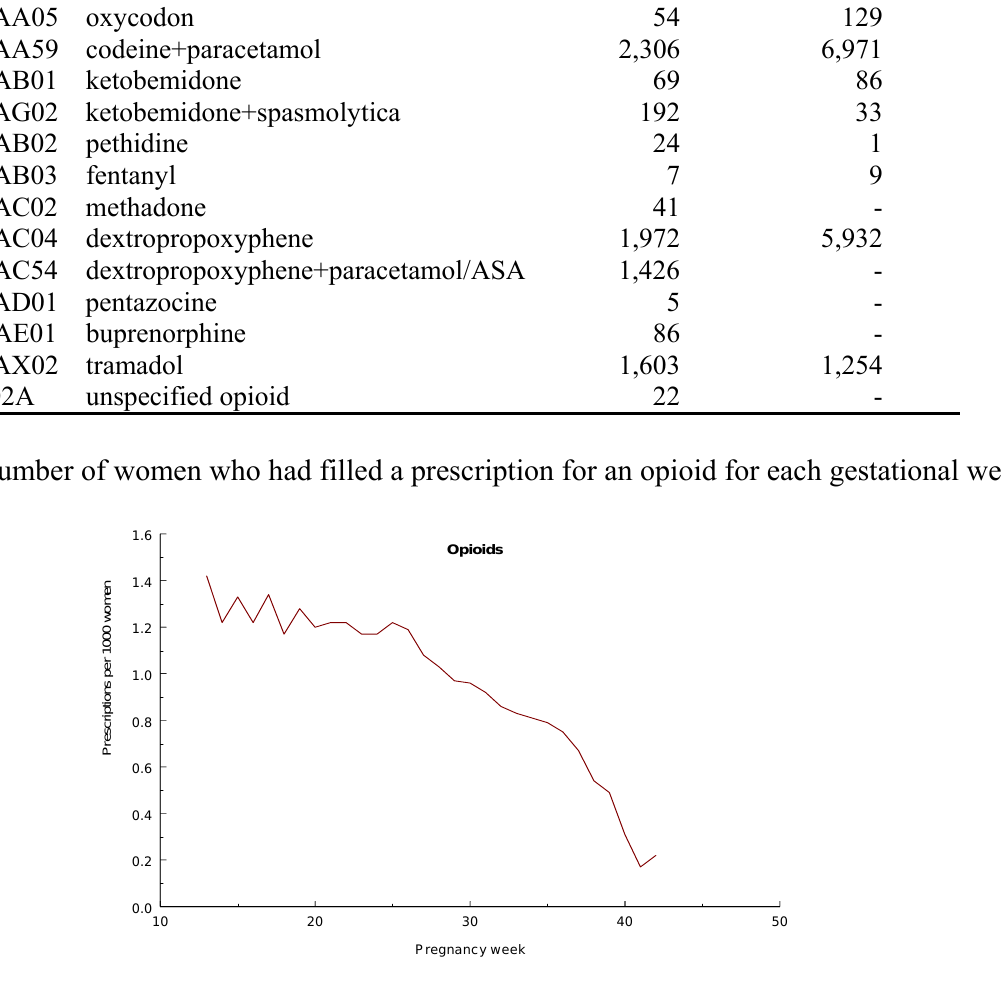
Table 8. Congenital malformations among infants exposed to opioids in early pregnancy. ORs calculated if three or more outcomes. Bold text marks statistical